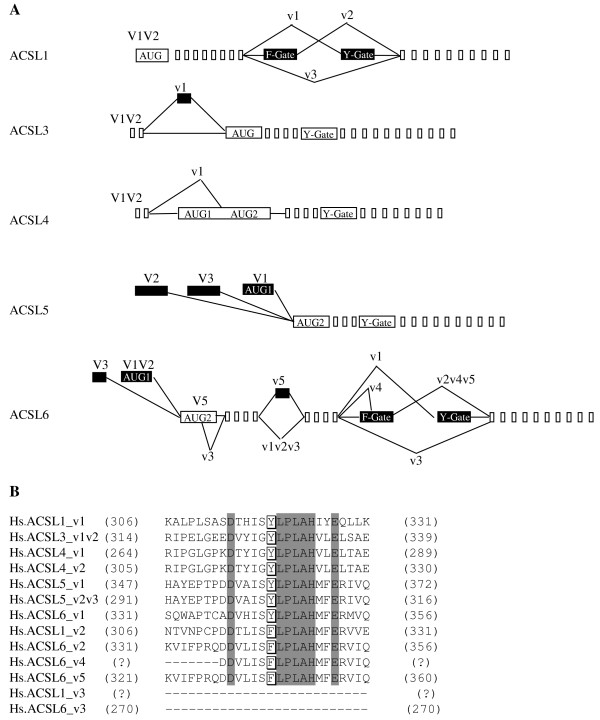
Human ACSL transcript variants (A) and gate domains (B). A: Schematic representation of the different known transcript variants. Exons are represented by empty boxes and alternative exons by filled boxes. Translation initiator AUG and Y/F-Gate domain encoding exons are indicated. If known, a capitalized V indicates the first exon of each variant. Note that only the sequence of the Gate-domain region of ACSL1_v3 and ACSL6_v4 is known. See Results for details. B: Alignment of the Gate-domain motifs. The F and Y residues of the two Gate domains are boxed. Highly conserved residues are shaded. Note that more residues are conserved among human ACSL isoforms. Position of the first and last residues shown is indicated on the left and right, respectively. Note that only the Gate-domain region of ACSL1_v3 and ACSL6_v4 is known. For clarity, ACSL3 variant 1 and 2, and ACSL5 variant 2 and 3, which encode the same isoform, are annotated as ACSL3_v1v2 and ACSL5_v2v3, respectively.